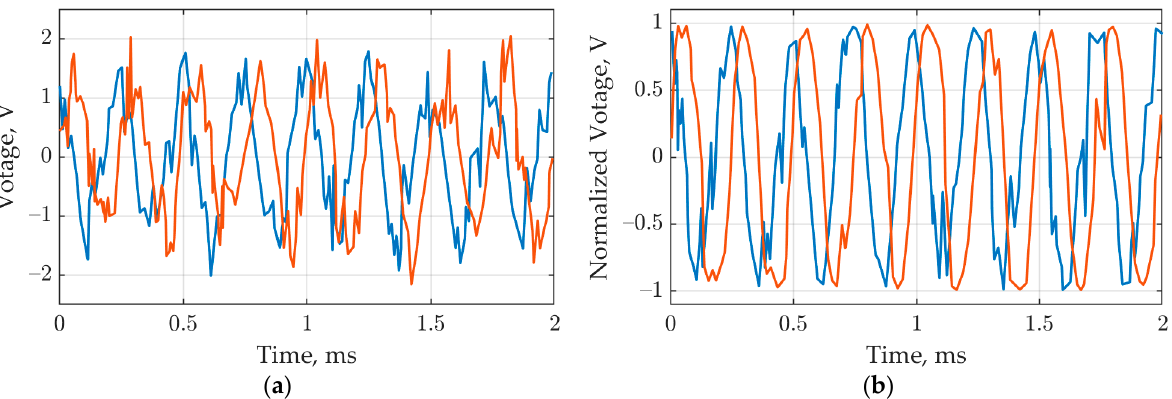
Figure 5. Discrete samples of the SFCW signal without normalization ( a ) and with normalization of samples ( b ). The in-phase components of the signals are depicted with blue lines and the quadrature components are with red lines.